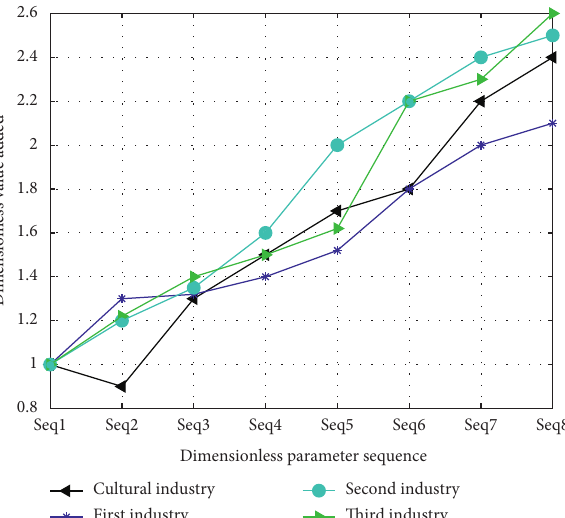
Figure 2: Numerical comparison diagram of the value added of cultural industry and the value added of three major industries after dimensionless